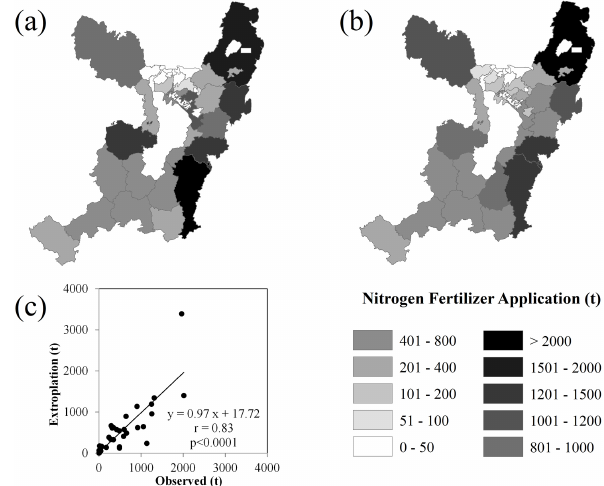
Figure 6. Comparison of N fertilizer use between (a) observed and (b) extrapolated values in the 35 towns of Xishan, Guandu, Jinning and Chenggong counties in 2007. The size of the towns is small, varying from 3km 2 to 424km 2 , with an average of 86km 2 , less than half of the average area of catchments in the basin. Data ex- trapolated from the county using the land use-weighting method is in good agreement with actual